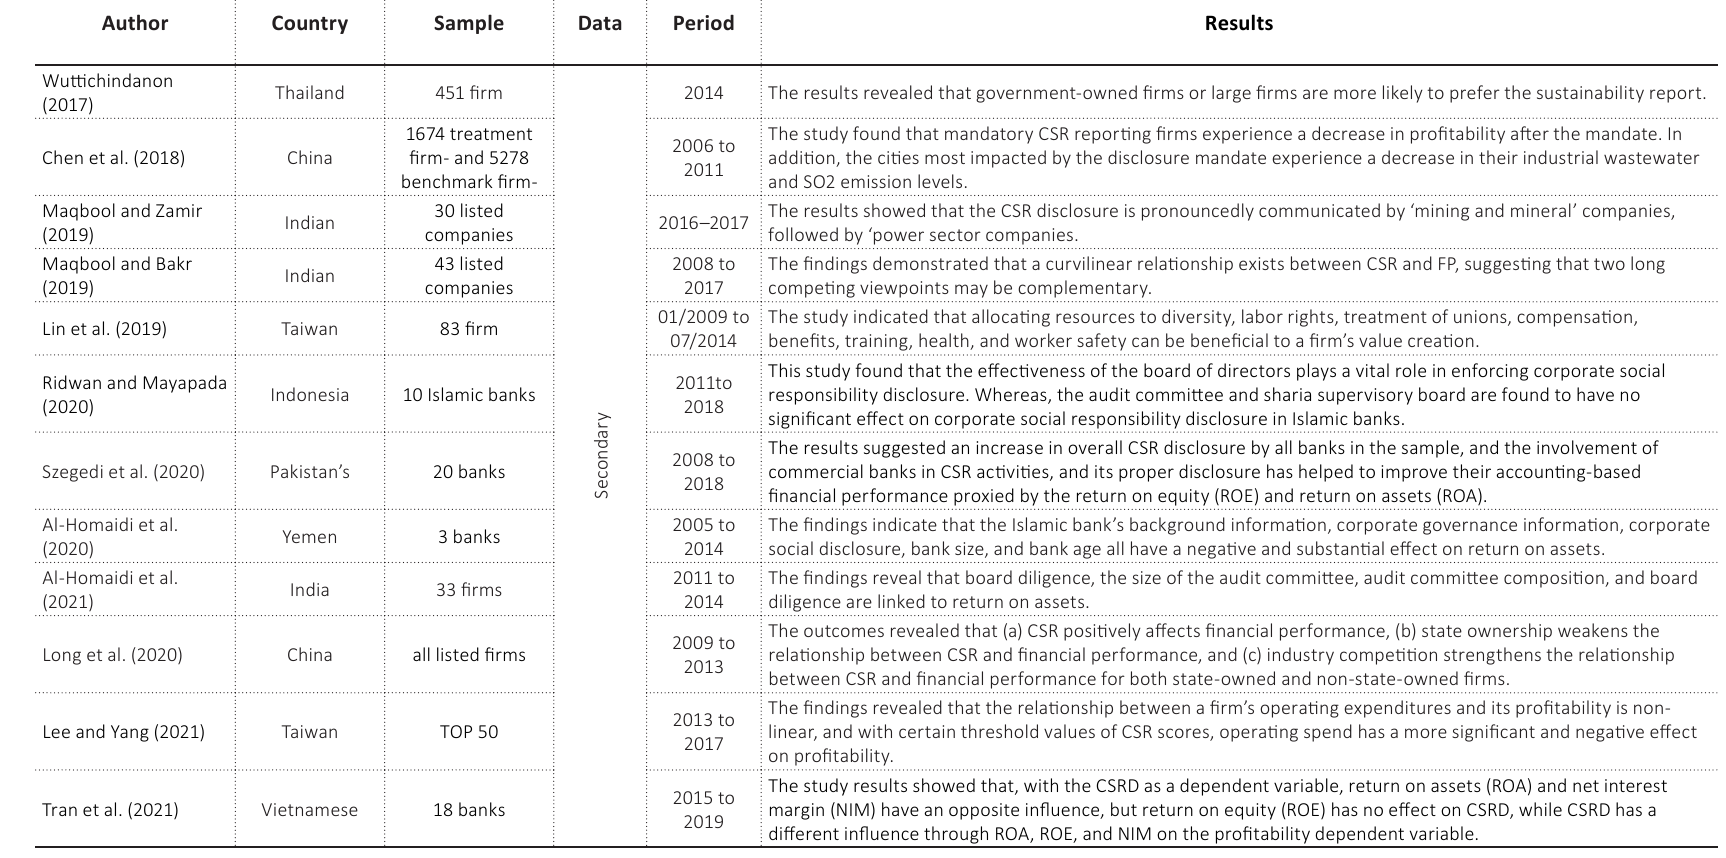
Table 1 (cont.). Some empirical articles that examined the link between CSD and financial